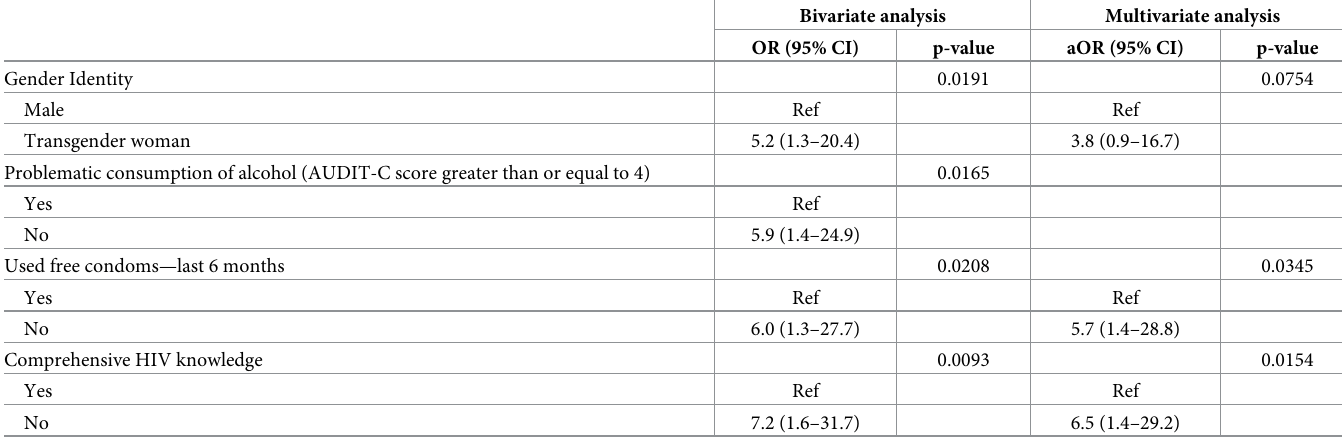
Table 3. Factors associated with being unaware of having HIV among MSM and TGW in Bamako, Mali 2014–2015.